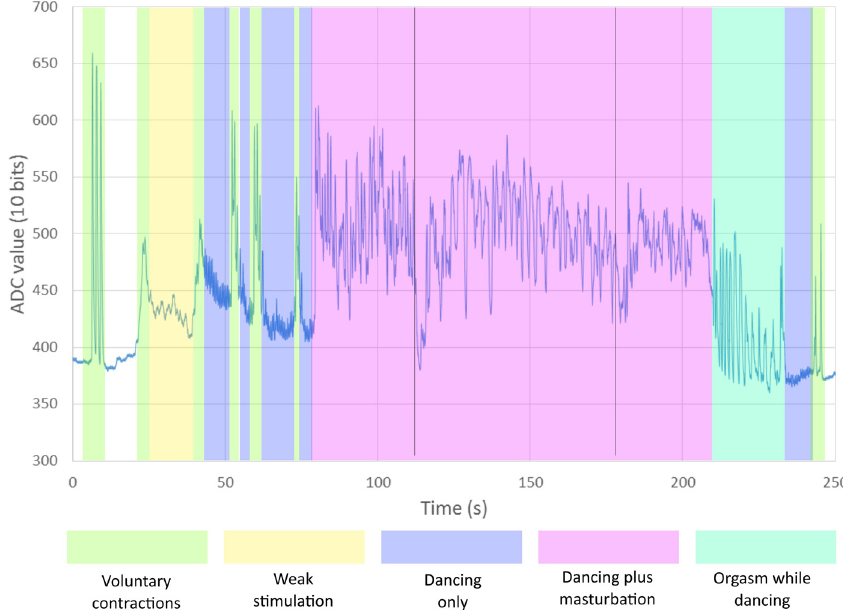
Figure 33: Anal sphincter tension recorded during masturbation and orgasm while